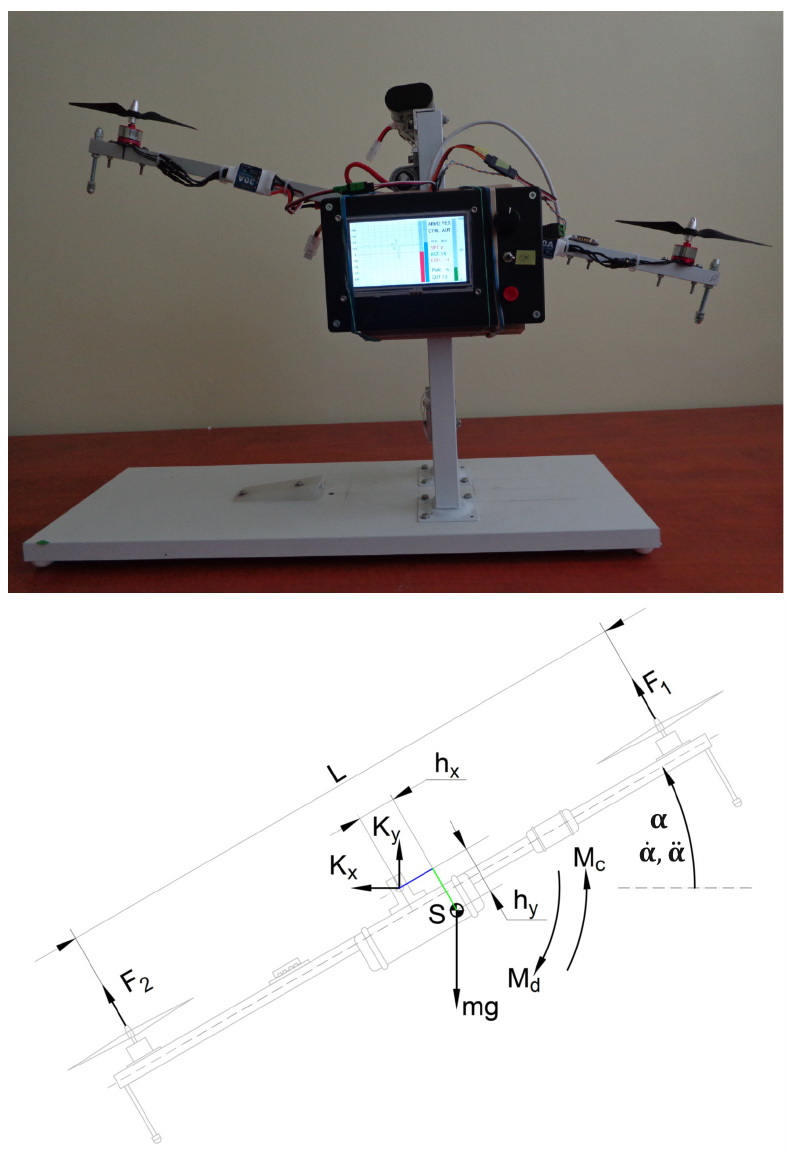
Figure 3. ( Above ) The double rotor test stand; ( Below ) Free body diagram of the bar, belonging to the double rotor